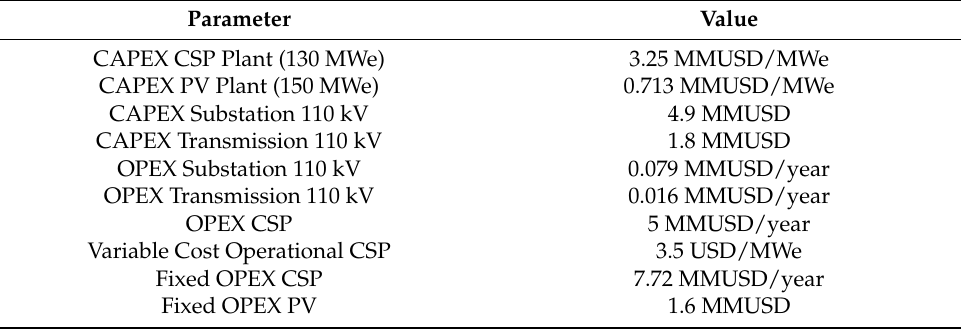
Table 9. Cost distribution for economic evaluation. MMUSD: Millions of